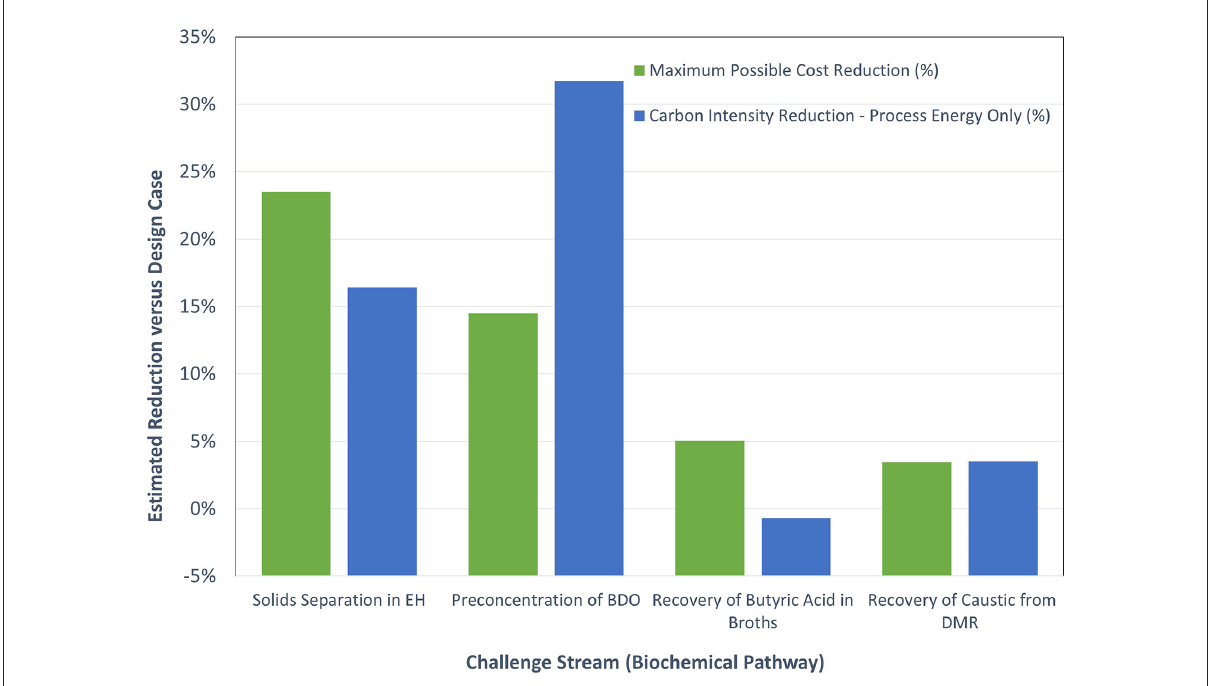
FIGURE7 Estimated cost and process energy reductions for the biochemical separation challenge stream